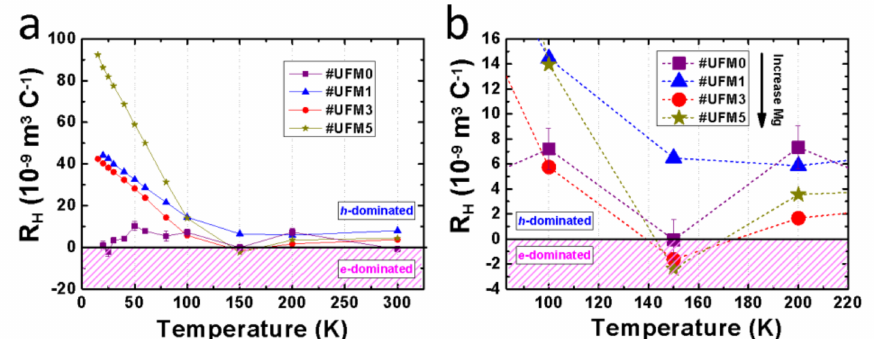
Figure 3. Hall coefficient R H as a function of temperature for #UFM0, #UFM1, #UFM3 and #UFM5. ( a ) R H - T plots in a temperature range from 20 K to 300 K; ( b ) A magnified area from 90 K to 220 K, showing the phenomenon of sign reversal in #UFM3 and